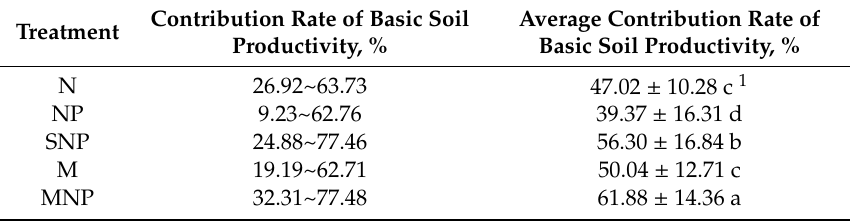
Figure 4. The trend of the contribution percentage of basic soil productivity to yield under different fertilizations, 1981–2016. Table 4. The effect of fertilization on basic soil yield and contribution rate.